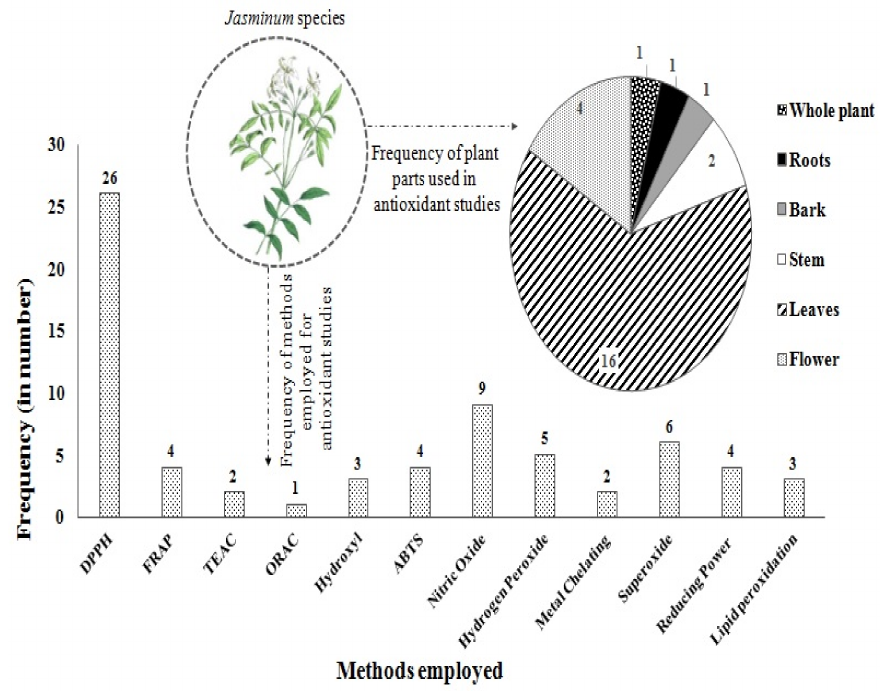
Figure 4. Frequency of method employed and plant parts used in antioxidant